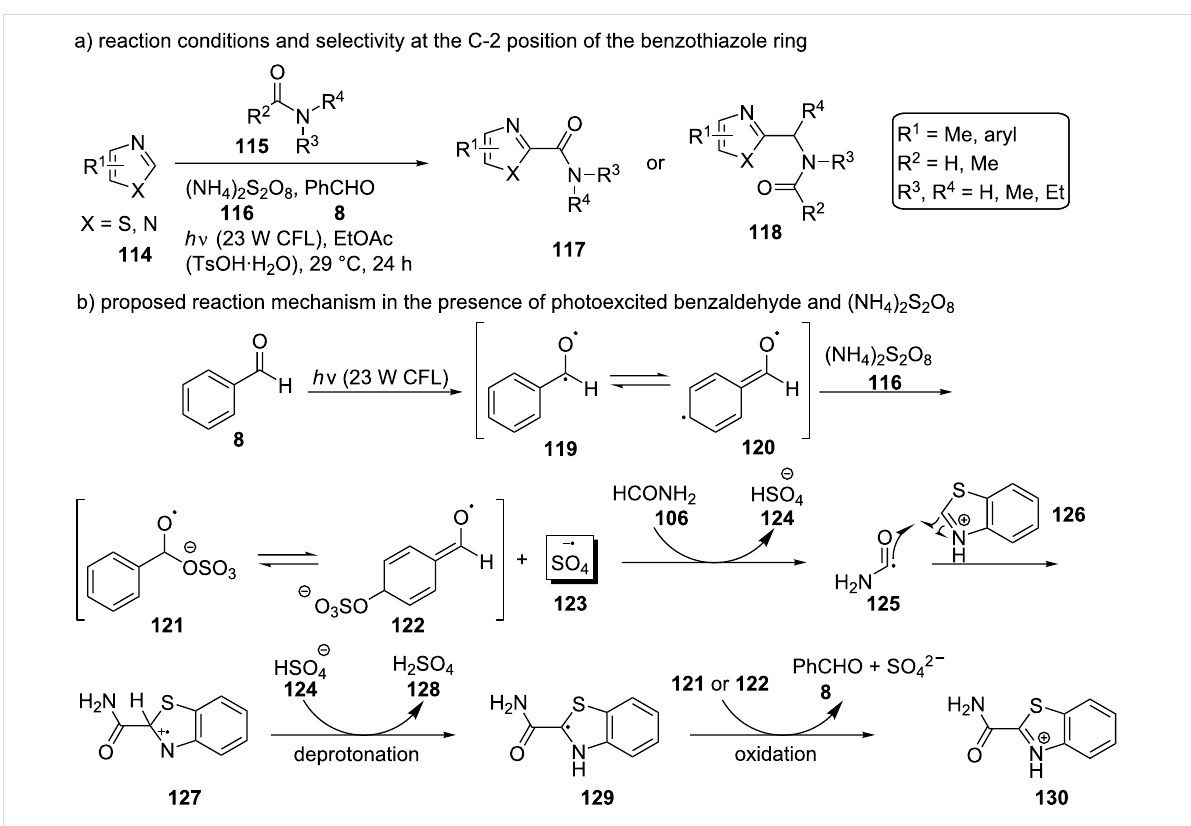
Scheme 27: Photoredox cross-dehydrogenative coupling (CDC) conditions and proposed reaction mechanism.